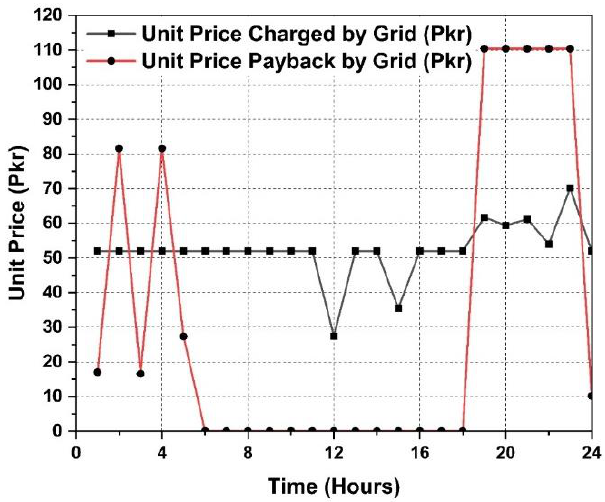
Figure 14. On − grid costing for one day. Grid intake cost = PKR 1253.4; Grid payback cost = PKR 786.3238; Total on-grid model cost = Grid intake cost-Grid payback cost = PKR 467.08